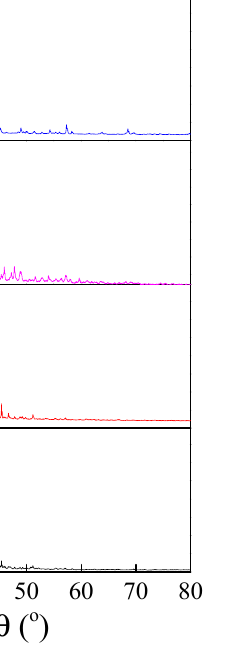
Figure 7. XRD patterns of polycrystalline powders corresponding to ligand and complexes.